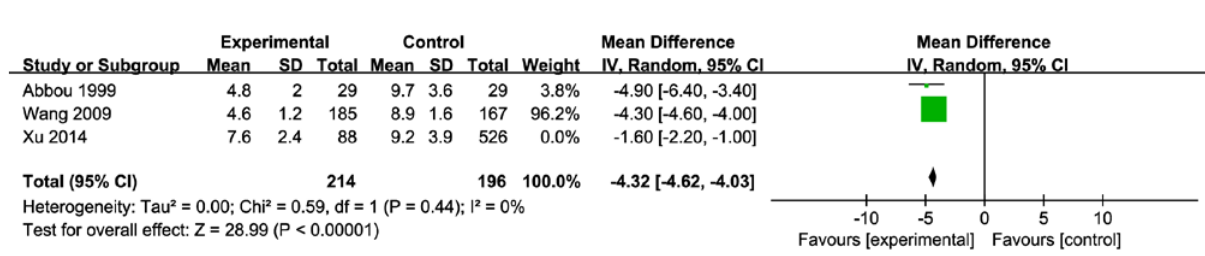
Figure 3: The forest plot for the operative blood loss between LRN and ORN group